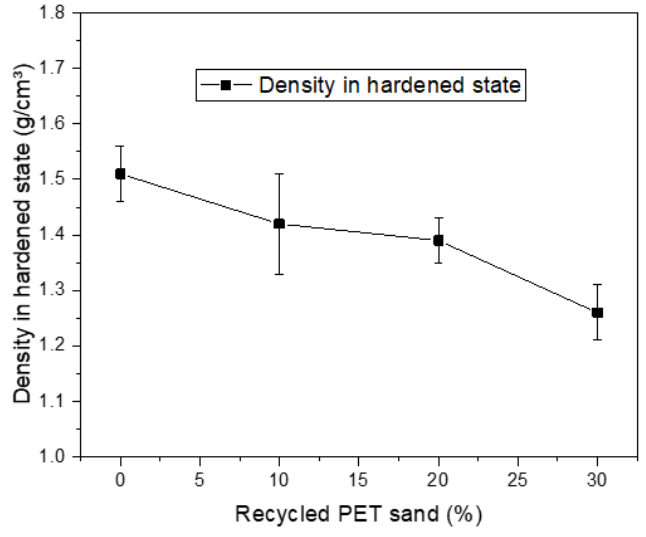
Figure 7. Density results in the hardened state.